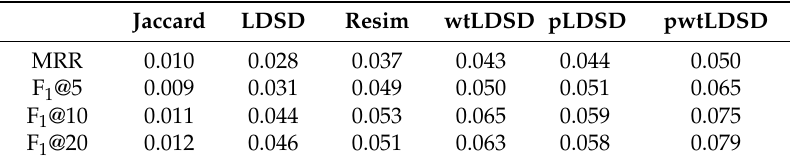
Table 1. Experiment Results.